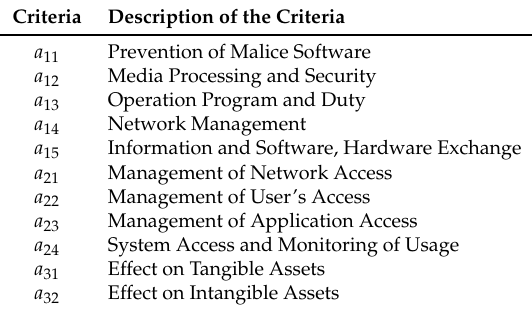
Table 1. Criteria of the bottom level